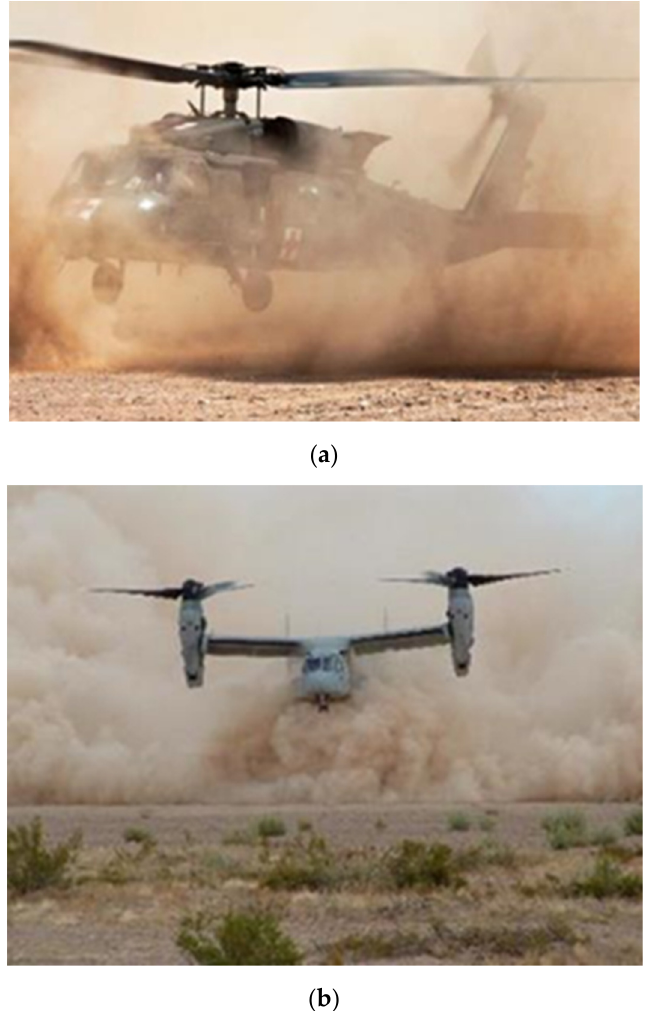
Figure 1. Harsh sand dust cloud conditions experienced by vertical take-off and landing aircraft during take-off, landing or hovering flight operations over sandy terrain. ( a ) Rotorcraft landing operation on sandy terrain; ( b ) tilt rotor aircraft take-off/hovering operation over sandy terrain.